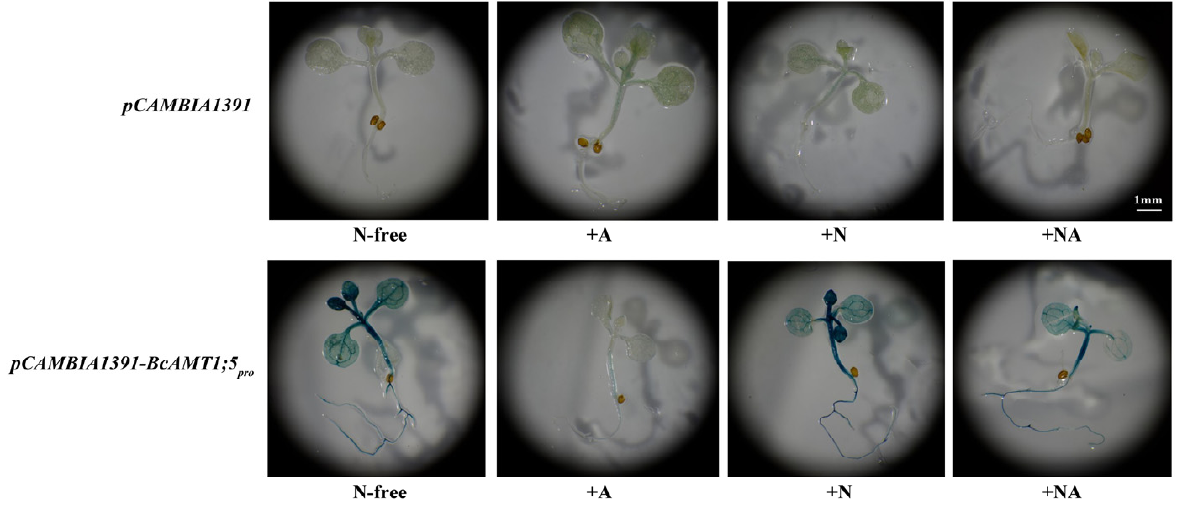
Figure 8. Histochemical staining for glucuronidase (GUS) activities in Arabidopsis seedlings trans- formed with pCAMBIA1391 and pCAMBIA1391-BcAMT1;5 pro ::GUS . Transgenic seedlings were sub- jected to N-free treatment for 4 d and supplied with 0.25 mmol L − 1 NH 4 + , 0.25 mmol L − 1 NO 3 − , a mixture of 0.1875 mmol L − 1 NO 3 − , and 0.0625 mmol L − 1 NH 4 + for 2 h after N-free treatment. +A, +N, and +NA indicate NH 4 + , NO 3 − , as well as the mixture of NO 3 − and NH 4+ ,